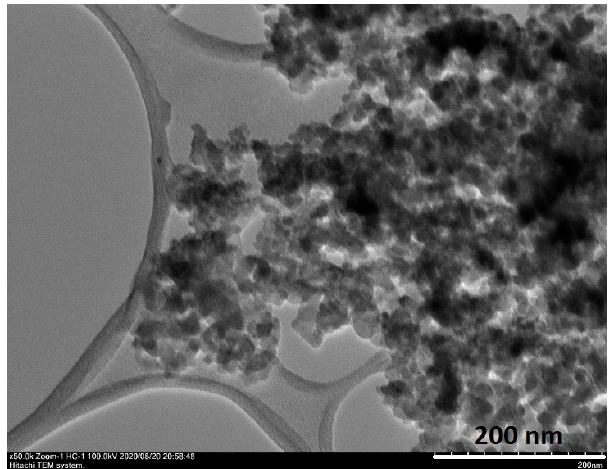
Figure 9. TEM samples prepared using the “nano fishing” procedure: Pd (OAc) 2 and 6b in chloroform.